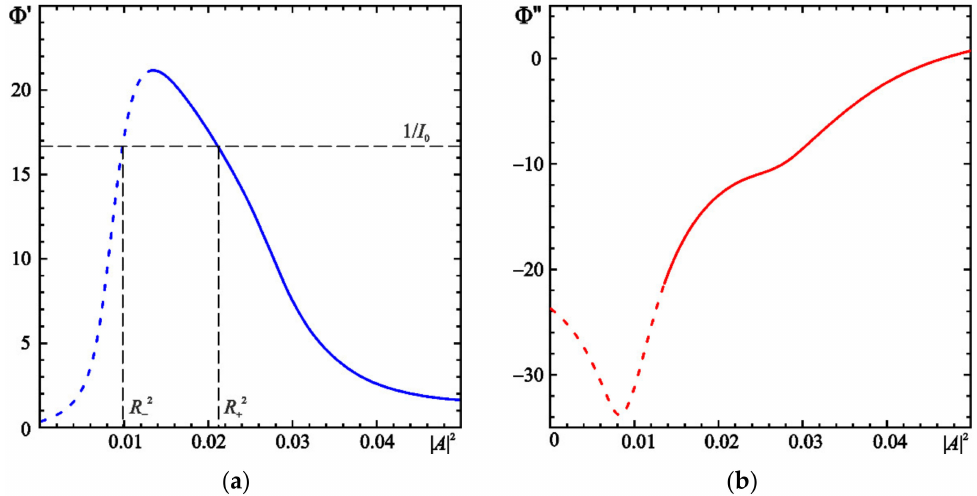
Figure 1. Active ( a ) and reactive ( b ) electronic susceptibility versus | A | 2 calculated at µ = 15.0 and ∆ = 0.534. Stable and unstable states are shown with solid and dotted lines, H